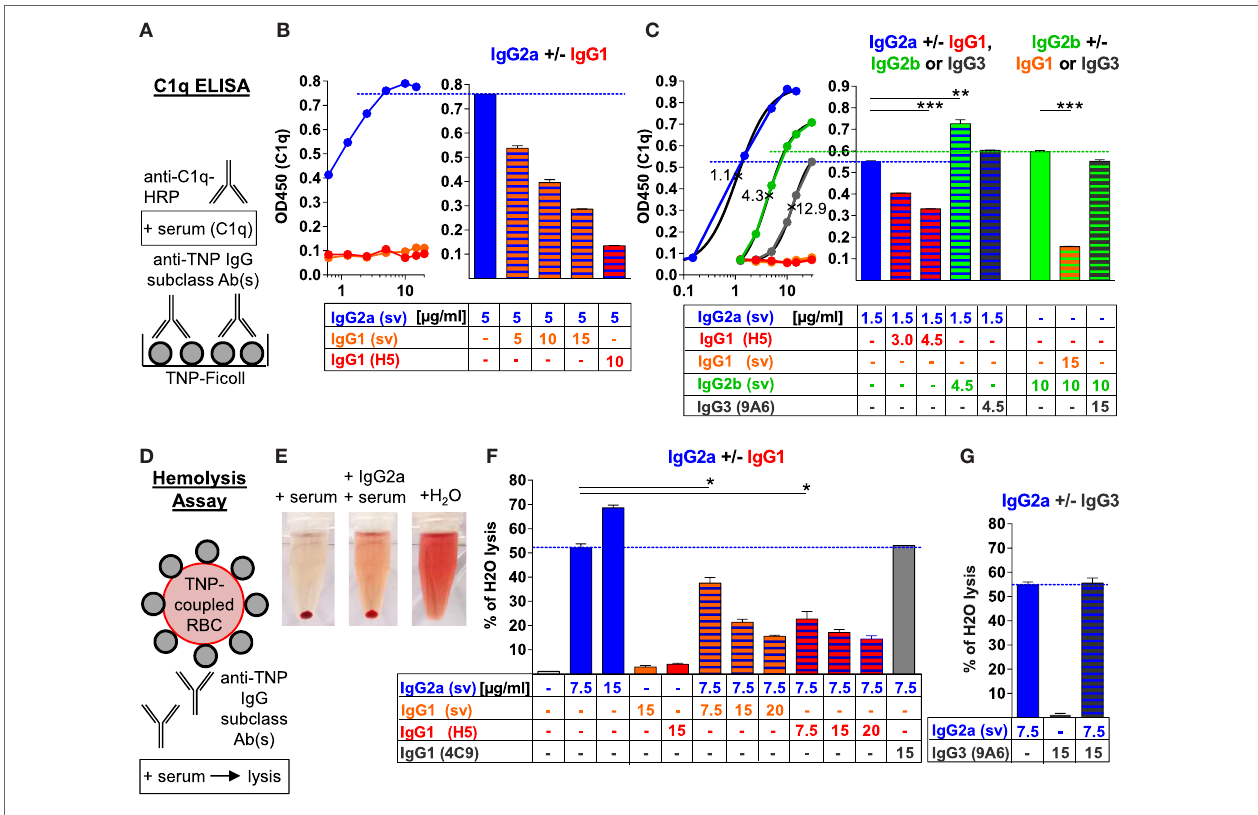
FiGUre 1 | Murine IgG1 prevents C1q binding and complement activation by IgG2a, IgG2b, or IgG3 antibodies (Abs) in an antigen-specific manner. (A) Schematic description of the C1q ELISA applied in panels (B,c) and Figure S1 in Supplementary Material. 2,4,6-Trinitrophenyl (TNP)-Ficoll-coupled 96-well plates were incubated with different concentrations of one or two anti-TNP monoclonal IgG subclass Abs [anti-TNP IgG1 (clone H5; red), IgG3 (clone 9A6; gray) as well as IgG1 (orange), IgG2a (blue), and IgG2b (green) class-switch variants (sv; with identical VDJ sequences)] and subsequently with C1q-containing serum; C1q was detected with an anti-C1q-HRP-coupled secondary Ab system. (B,c) Mean of the resulting C1q ELISA values measured at 450 nm (OD450) with the indicated ( μ g/ml) single or paired anti-TNP IgG subclass Abs ( n = 2). IgG subclass-specific half-maximal effective concentrations (EC50; × ) were calculated by the interpolated subclass-specific C1q-binding curves in panel (c) ( R 2 > 0.99). (D) Schematic description of the applied red blood cell (RBC)-lysis assay. TNP-coupled RBCs (Figure S1E in Supplementary Material) were incubated with one or two anti-TNP monoclonal IgG subclass Abs or an anti-ovalbumin IgG1 (clone 4C9) Ab and subsequently treated with serum containing C1q and further complement components. (e) Exemplary hemolysis approach with centrifuged TNP-coupled RBCs after reaction with serum, serum plus anti-TNP IgG2a or H 2 O as a positive control (100% lysis). (F,G) Mean of the resulting RBC lysis [measured hemoglobin (OD 414 nm) in the supernatant of centrifuged RBCs], which was calculated as the percentage of H 2 O-induced positive control RBC lysis (100%; maximum of the y -axes) with the indicated ( μ g/ml) single or paired IgG subclass Abs ( n = 2). The results from one of at least two independent experiments are